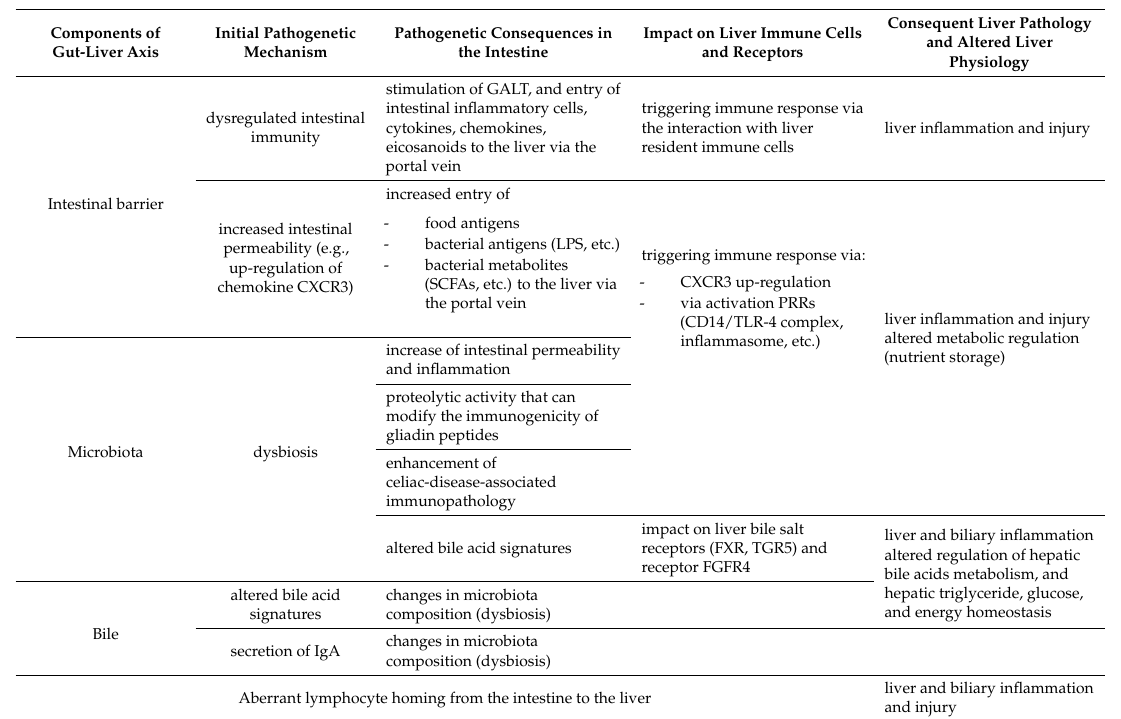
Table 1. A role of the components of gut–liver axis in putative pathogenesis of liver injury in celiac